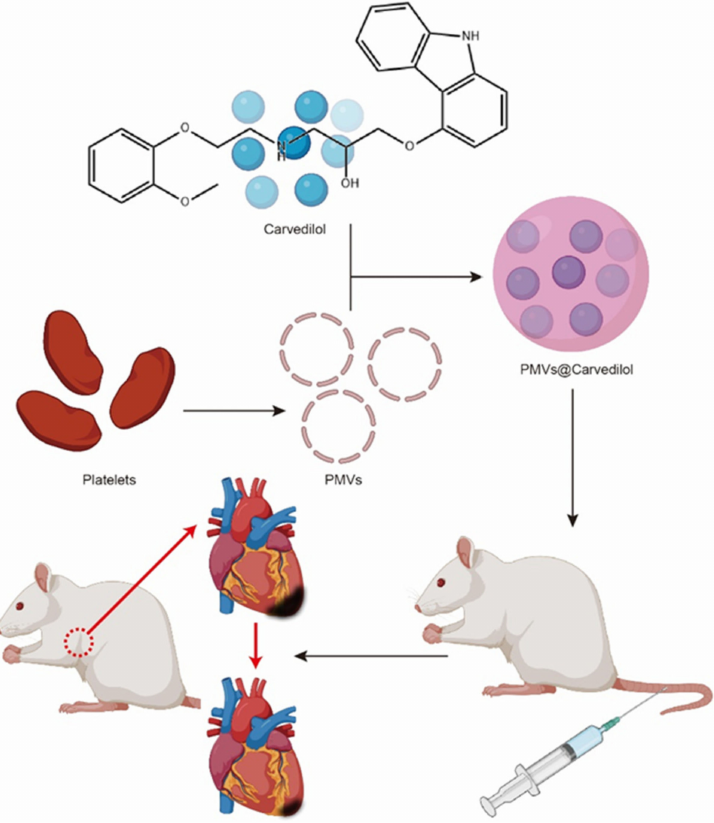
Figure 1. Schematic diagram of PMVs@Carvedilol fabrication and its targeted therapy towards myocardial ischemia–reperfusion